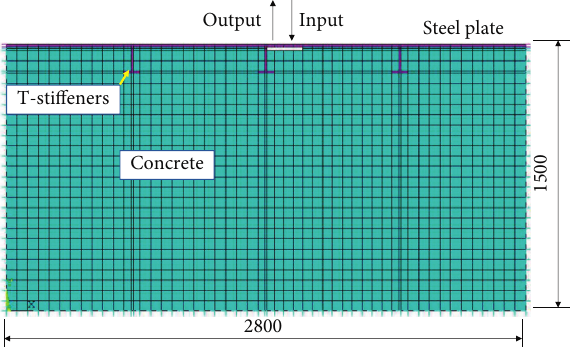
Figure 3: The compartment calculation model of steel shell concrete immersed tube tunnel